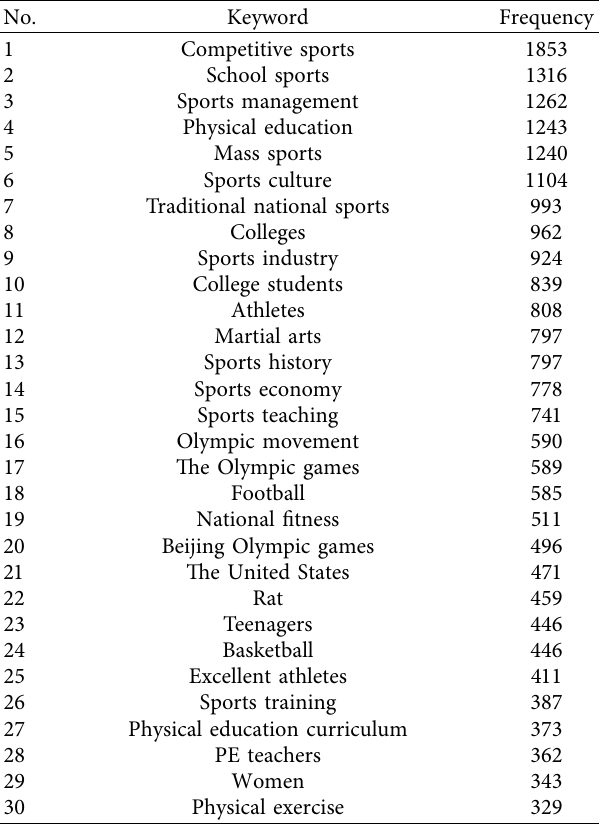
Figure 5 is the trend of keyword, sports management.